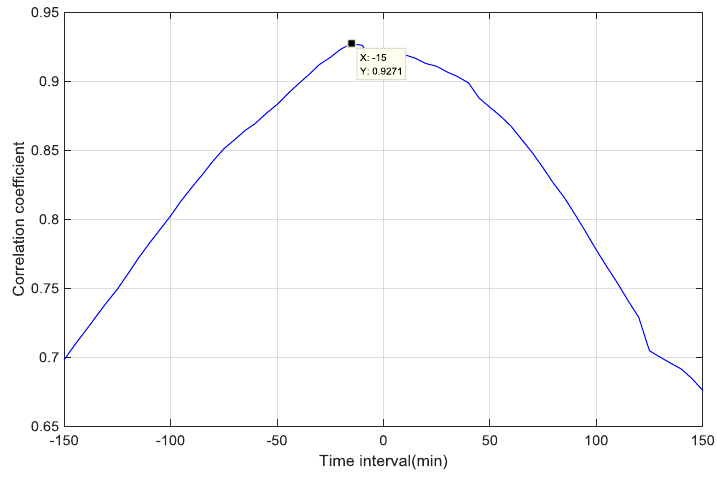
Figure 9. Linear correlation coefficients with different shifted time intervals